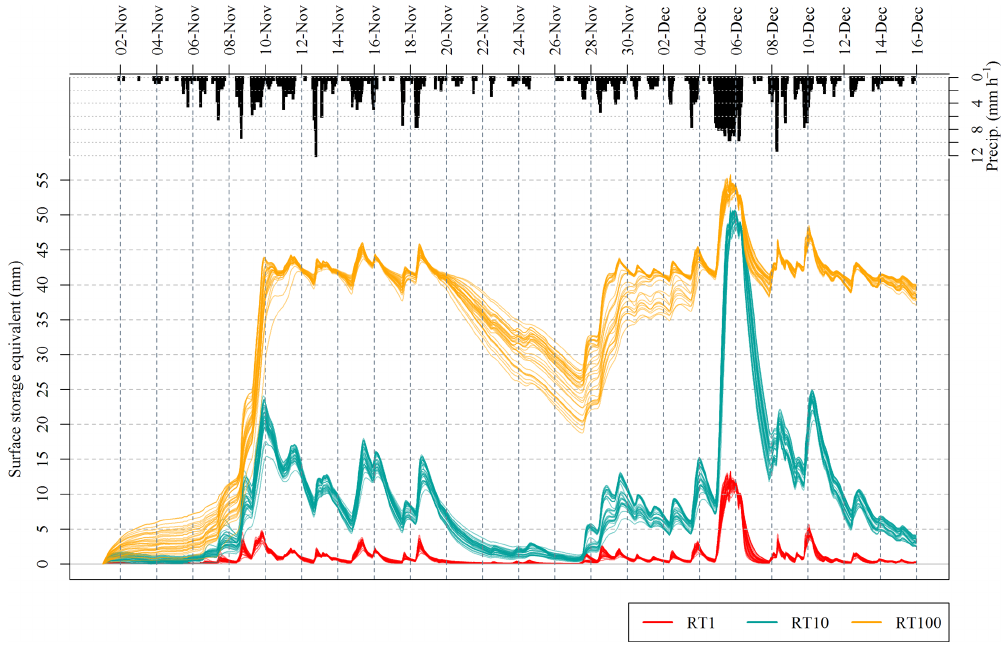
Figure 6. Surface excess storages, expressed as specific rainfall equivalent, across one of the lumped RAF units with maximum storage 1m through a single intervention case and for the three mean residences times considered. The slight excess at the peaks of the storm reflects the weir crest height of the overflow function